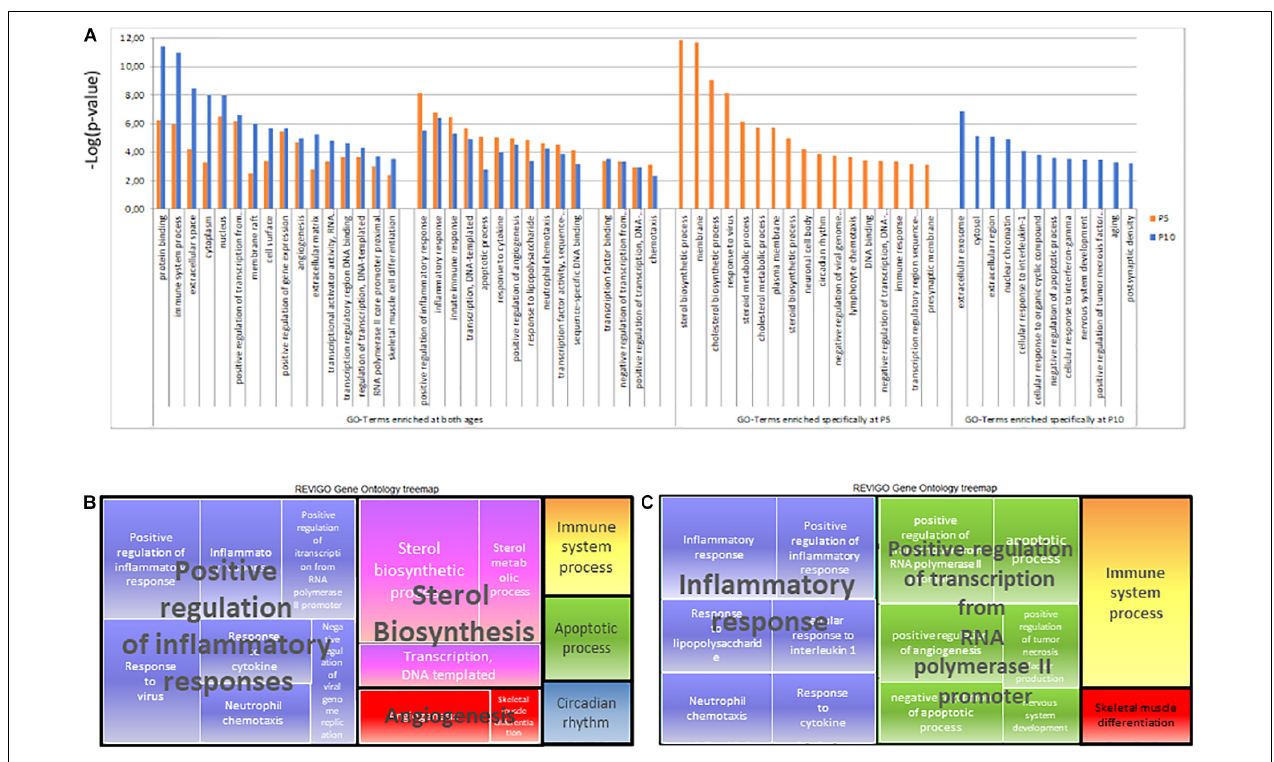
FIGURE 8 | Gene ontology analysis of P5 or P10 lists of genes affected after HI. (A) List of terms identified using David and selected at dispensability score < 0.7 using Revigo. Enrichment significance was shown as –log( p -value) according to BH corrected t -test at P5 (orange) and P10 (blue). (B) Treemap of Biological Processes GOterms in P5 brain. (C) Treemap of Biological Processes GOterms in P10